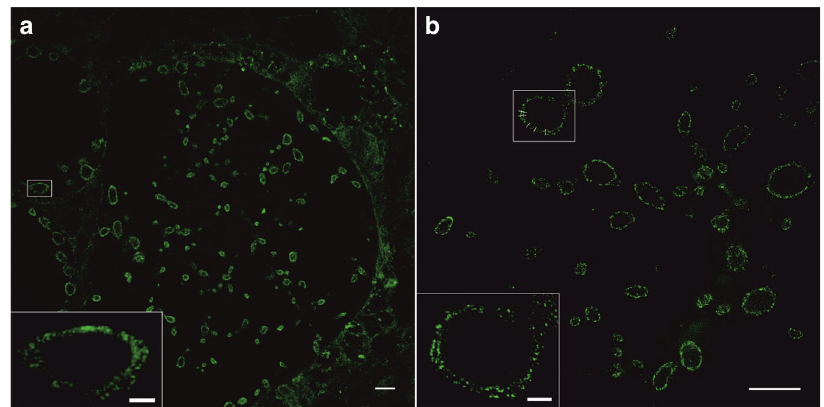
Fig. 4 10x Sphingolipid ExM in combination with SIM resolves the distance between the OM and IM of gram-negative bacteria. HeLa229 cells infected with Chlamydia trachomatis for 24 h, fed with α -NH 2 - ω -N 3 -C 6 -ceramide, fi xed, permeabilized and click-labeled with DBCO-Alexa Fluor 488 (green). Confocal ( a ) and SIM images ( b ) disclose that ceramides are incorporated into the OM and IM. Fitting intensity cross sectional pro fi les at different positions by a bimodal Gaussian fi t resulted in a peak-to-peak distance of 27.6 ± 7.7 nm (s.d.) (Supplementary Figs. 22 and 23). The data were obtained from n = 3 independent experiments. Scale bars 10 µ m ( a , b ), 2 µ m